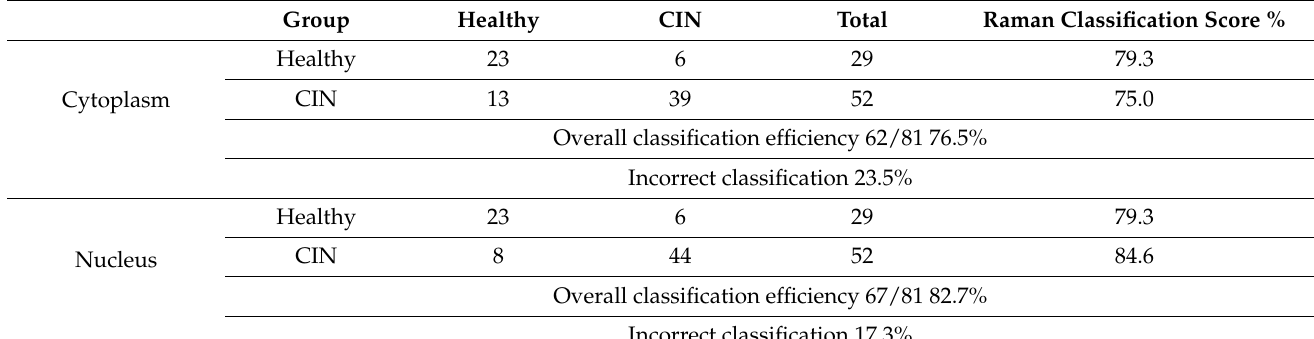
Figure 3. Canonical analysis of principal coordinates (CAP) of biochemical patterns. Samples of healthy patients (H, blue triangles) and CIN patients (CIN, red triangles). ( A ) Cytoplasmic analysis ( δ = 0.567, p = 0.0002) and ( B ) nuclear analysis ( δ = 0.767, p = 0.0001). HC = Health condition. CIN= cervical lesion. Euclidean distance-based analysis. Table 2. Model classification and cross-validation of Healthy and CIN samples from CAP